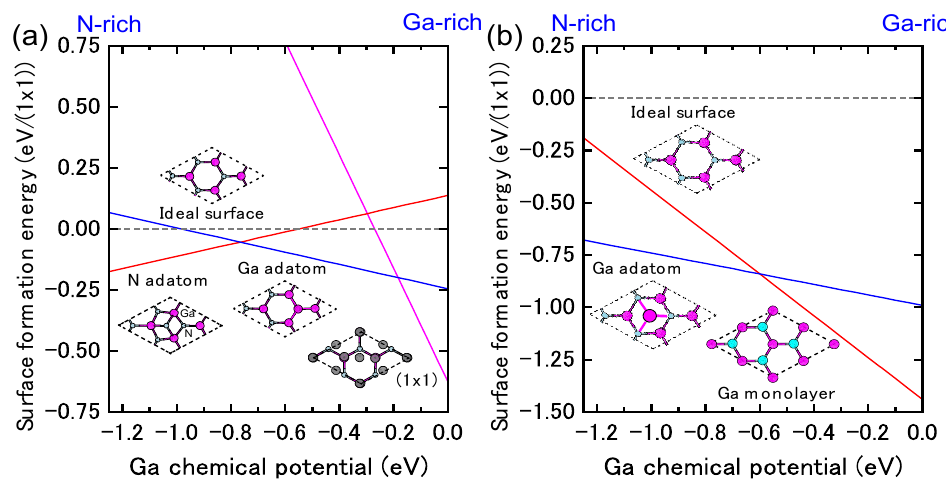
Figure 9. Calculated surface formation energies of polar GaN surfaces with ( a ) (0001) and _ ( b ) (0001 ) orientations as a function of Ga chemical potential. Schematics of the surface structures under consideration are also presented.